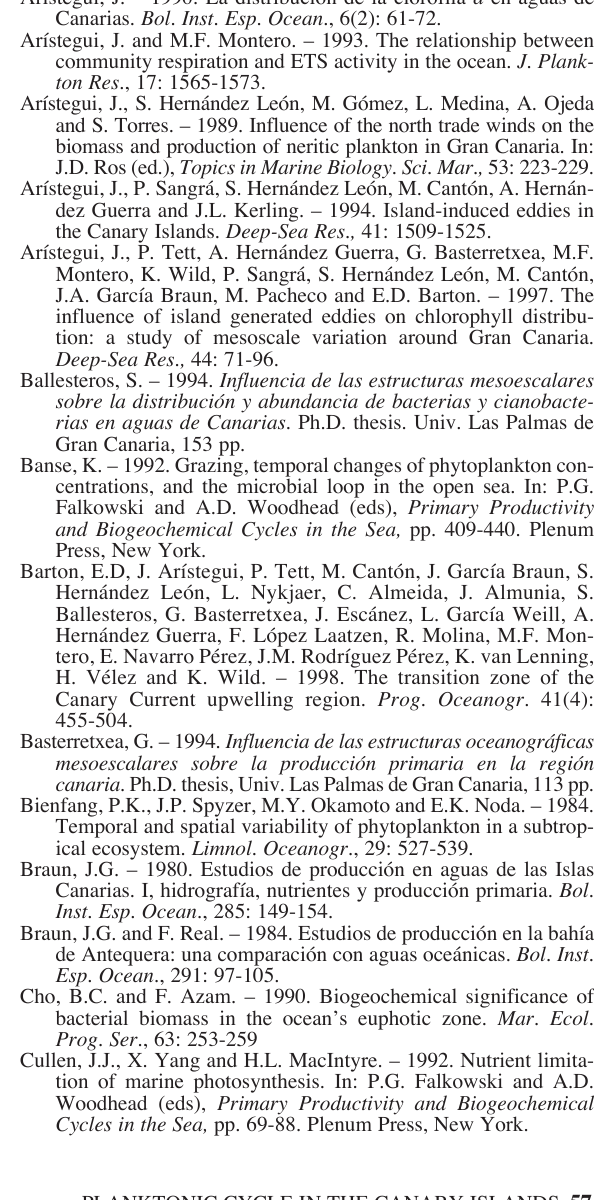
F IG . 6. – Relationship between the ratio of depth-integrated primary production and community respiration (P/R) and the depth-integrated primary production. The line represents the fitted regression equation, log P/R = -3.0 + 1.14 log P (R 2 = 0.75, P <0.0001, N =